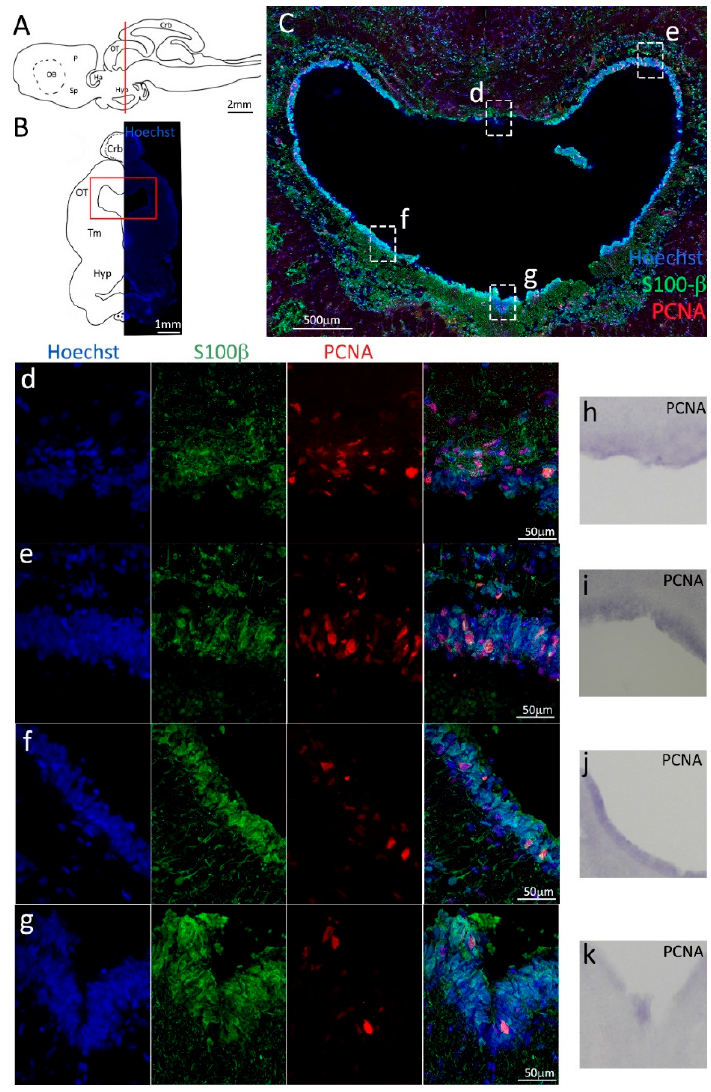
Figure 9. Localization of PCNA (red) and S100 β (green) positive cells in the mesencephalon of S. canicula . ( A ) Sagittal representation of S. canicula brain. The red line indicates the rostro-caudal localization of the section represented in the panel. ( B ) Coronal map of the area imaged. On the right, a real coronal section is stained with Hoechst 33342 to show nuclei distribution; on the left, a cartoon is drawn to indicate anatomical references. Red rectangle identifies the general area from which images are taken. ( C ) Mesencephalic neurogenic niche. Radial glial cell bodies (S100 β + , green) are localized around the ventricular wall and their processes spread into the surrounding tissue. Some S100 β + cells are also PCNA + (red), indicating the proliferative state of the stem cells. ( d , e ) Magnification of the neurogenic niche localized in the tectal region. ( f , g ) Magnification of the neurogenic niche localized in the tegmental area. ( h – k ) In situ hybridization for S. canicula pcna in tectal and tegmental areas of the mesencephalic neurogenic niche. Abbreviations: Crb: cerebellum, OT: optic tectum, Tm: tegmentum, Hyp: